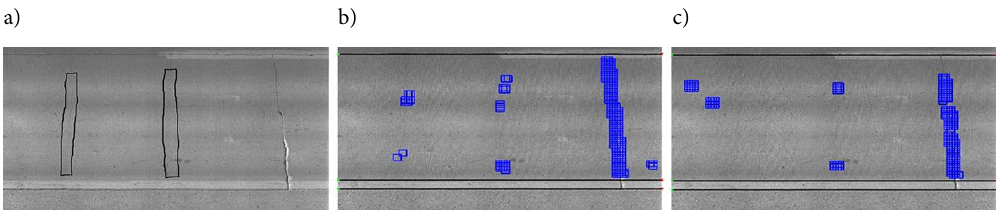
Figure 14. An example of combined low and high severity PCC pavement crack detection: a – actual image; b – shape-based crack detection; c – SVM based crack